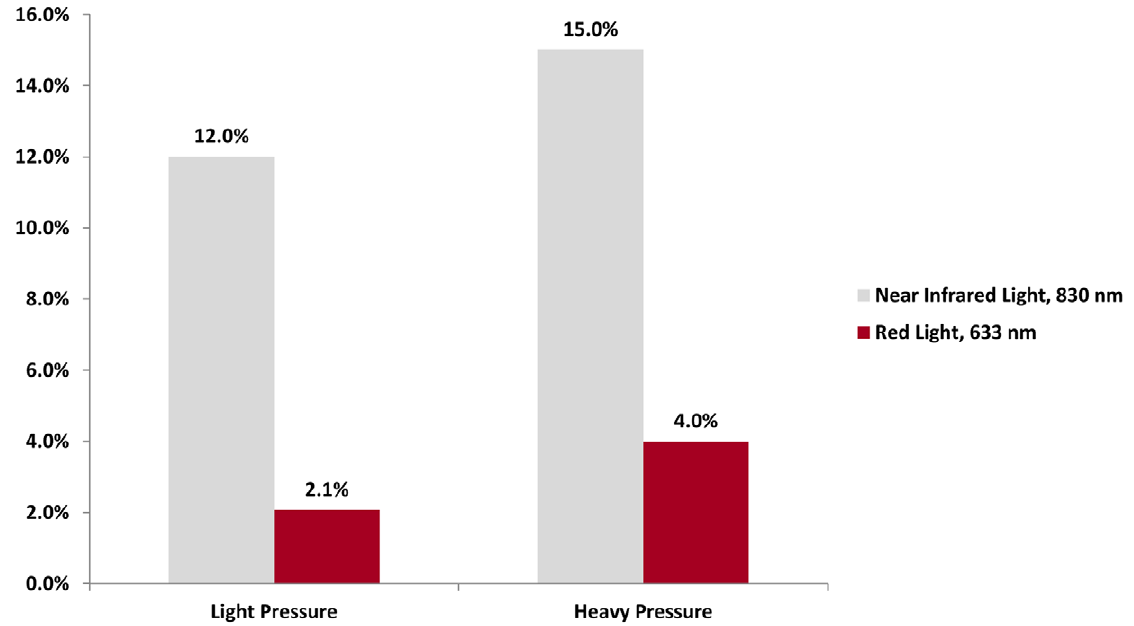
Figure 7. Percent Penetrance of Light through Human Cheek invivo. Transmission of near infrared light through a human cheek is significant, and is greater than transmission of red light.